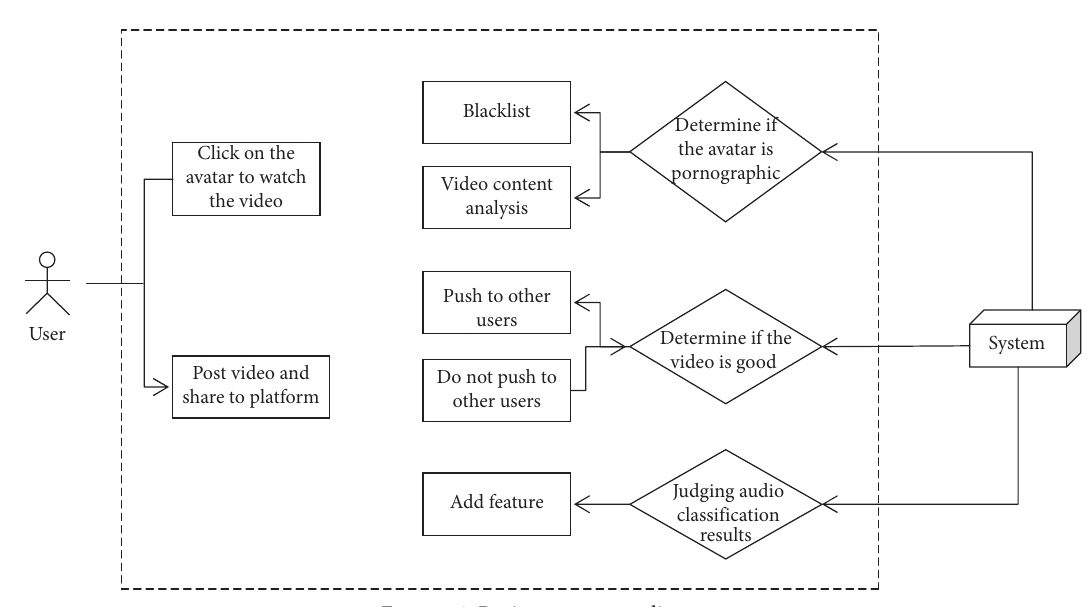
Figure 6: Business use case